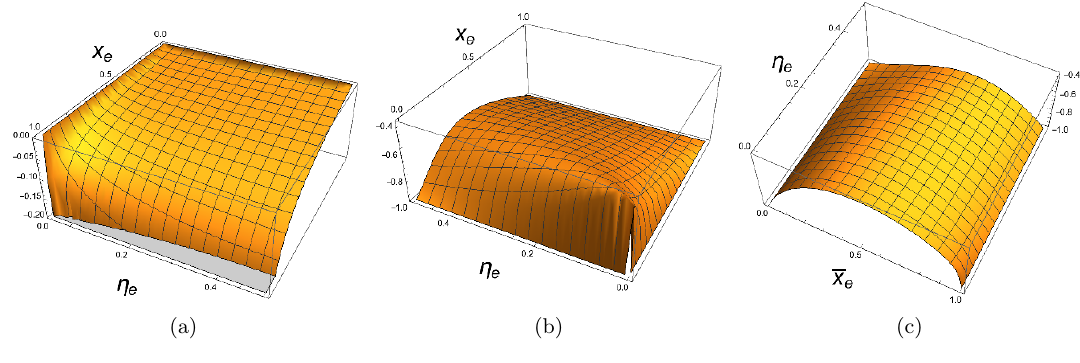
Figure 21 . Like (cid:12)gure 20 but for the f ( x e ; y e ) of